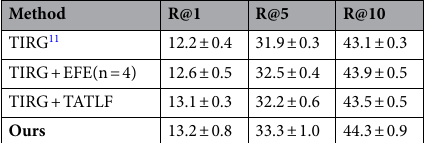
Table 4. Ablation studies of our method on MIT-States